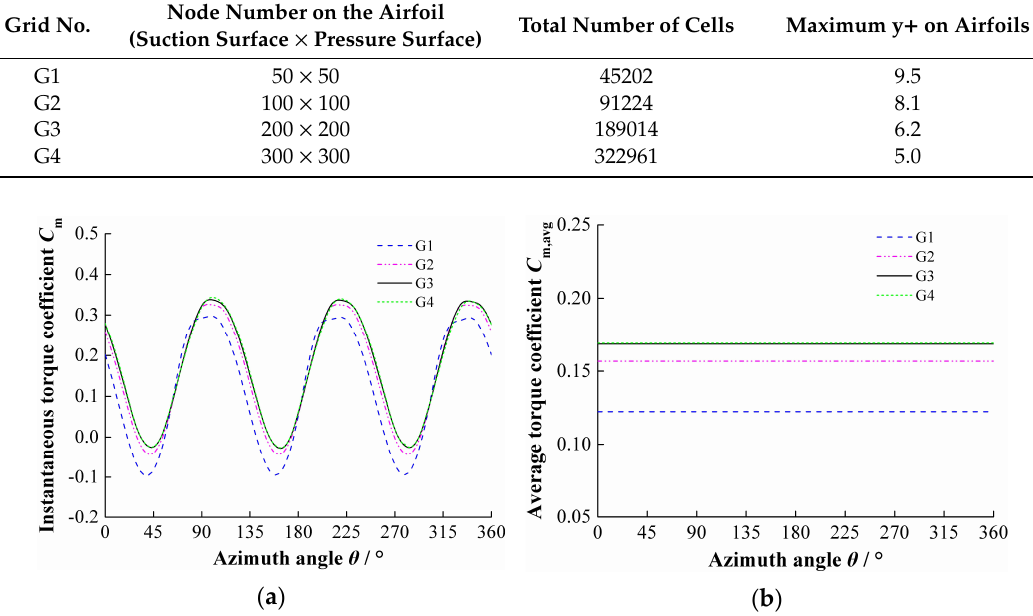
Figure 3. Simulation results of ( a ) C m and ( b ) C m,avg for four grids.